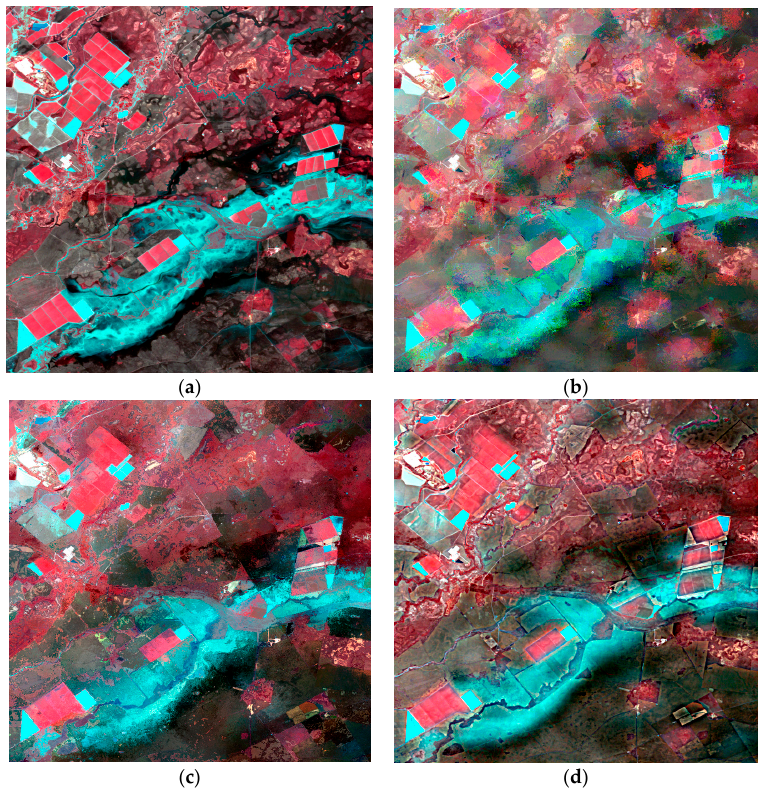
Figure 9. Comparison of the fusion results from the STARFM, FSDAF and RWSTFM methods for the third dataset: NIR-red-green composites of ( a ) the original Landsat image from 12 December 2004; ( b ) the predicted image using the STARFM; ( c ) the predicted image using the FSDAF; and ( d ) the predicted image using the RWSTFM. Table 5. The fusion results from the STARFM, FSDAF and RWSTFM methods evaluated using objective indices for the third dataset.